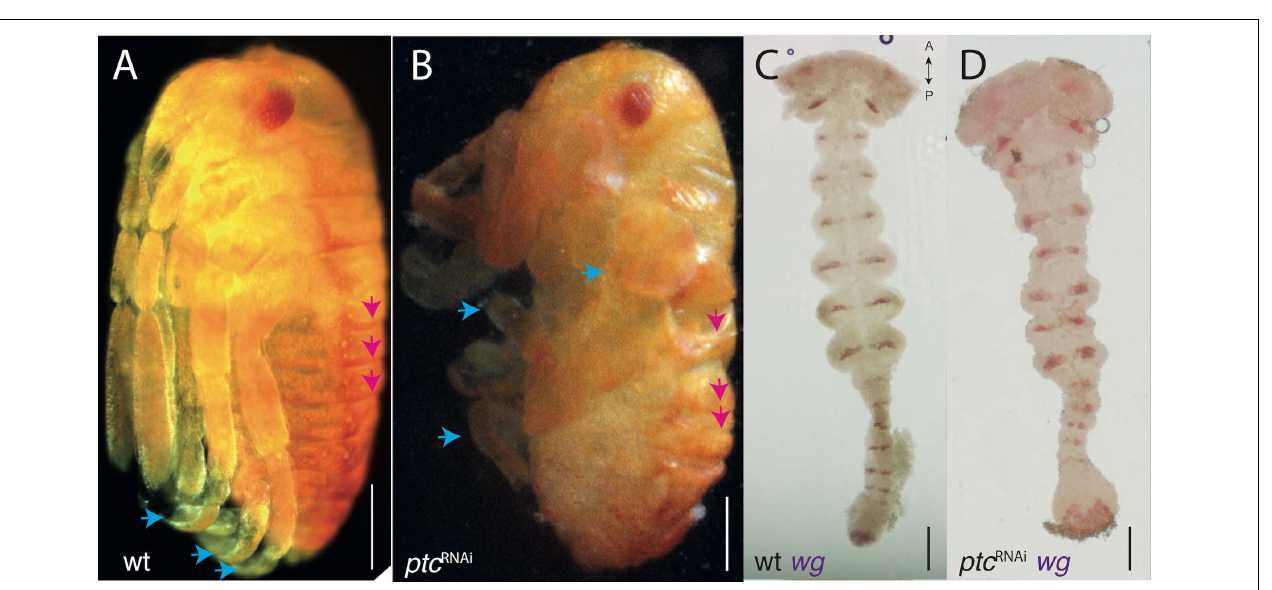
FIGURE 3 | ptc -RNAi phenotypes. (A) Wild-type hatchling (B) ptc -RNAi hatchling of the same age with disrupted segmental boundaries (pink arrows mark the first three abdominal segments) and limb deformities (blue arrows). Compare with (A) . (C) Wild-type expression of wg in the germband (same embryo from Figure 2E ). (D) ptc- RNAi expression of wg in the germband showing a normal head and mis-formed trunk segments. Axis labels: A, anterior, P, posterior. All scale bars are 200 µ